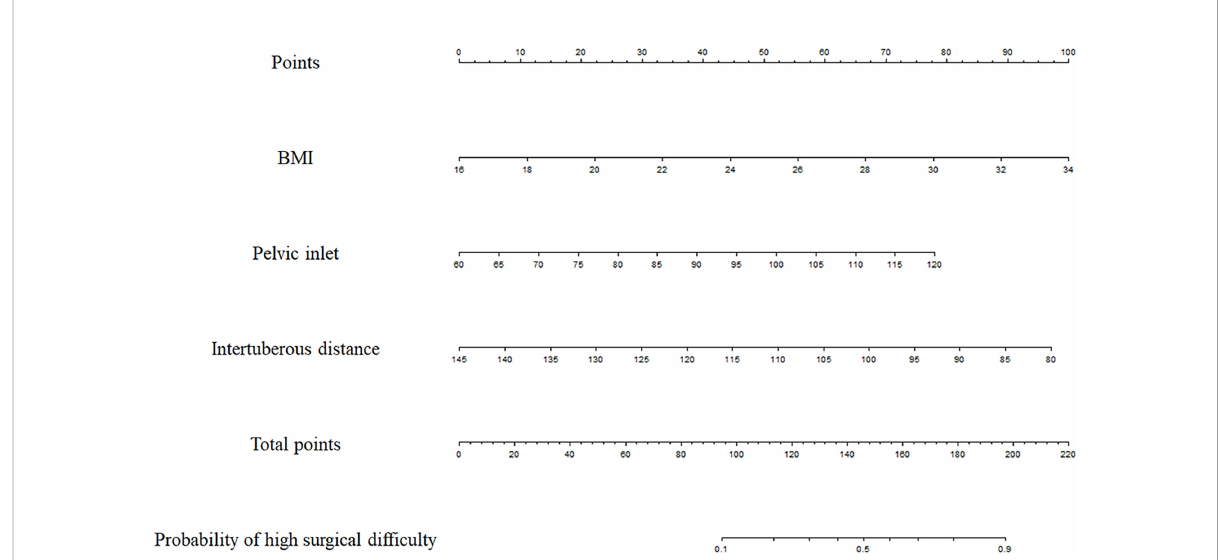
FIGURE 4 Prediction nomogram. In the nomogram, fi rst, a vertical line was drawn according to the value of the most in fl uential factors to determine the corresponding numbers of points. The total points were the sum of the above points. Then, a vertical line was drawn according to the value of total points to determine the probability of high surgical dif fi